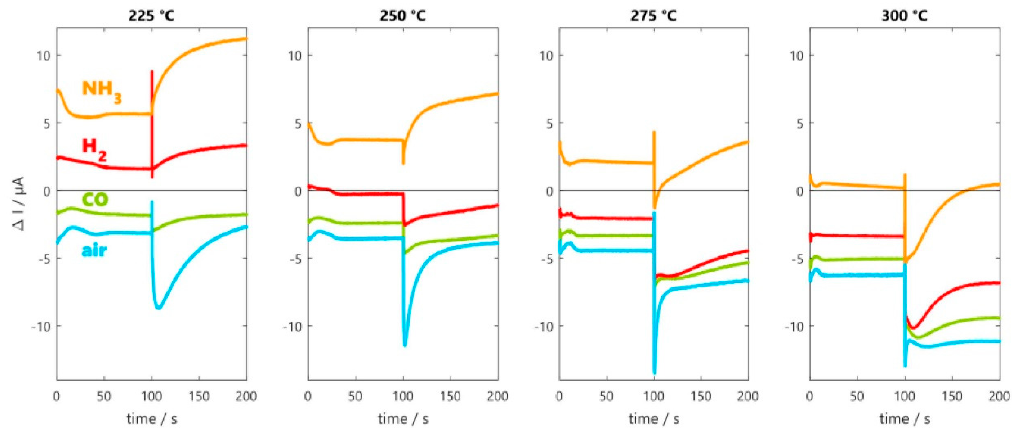
Figure 2. Difference signals with UV irradiation with the signal in N 2 as